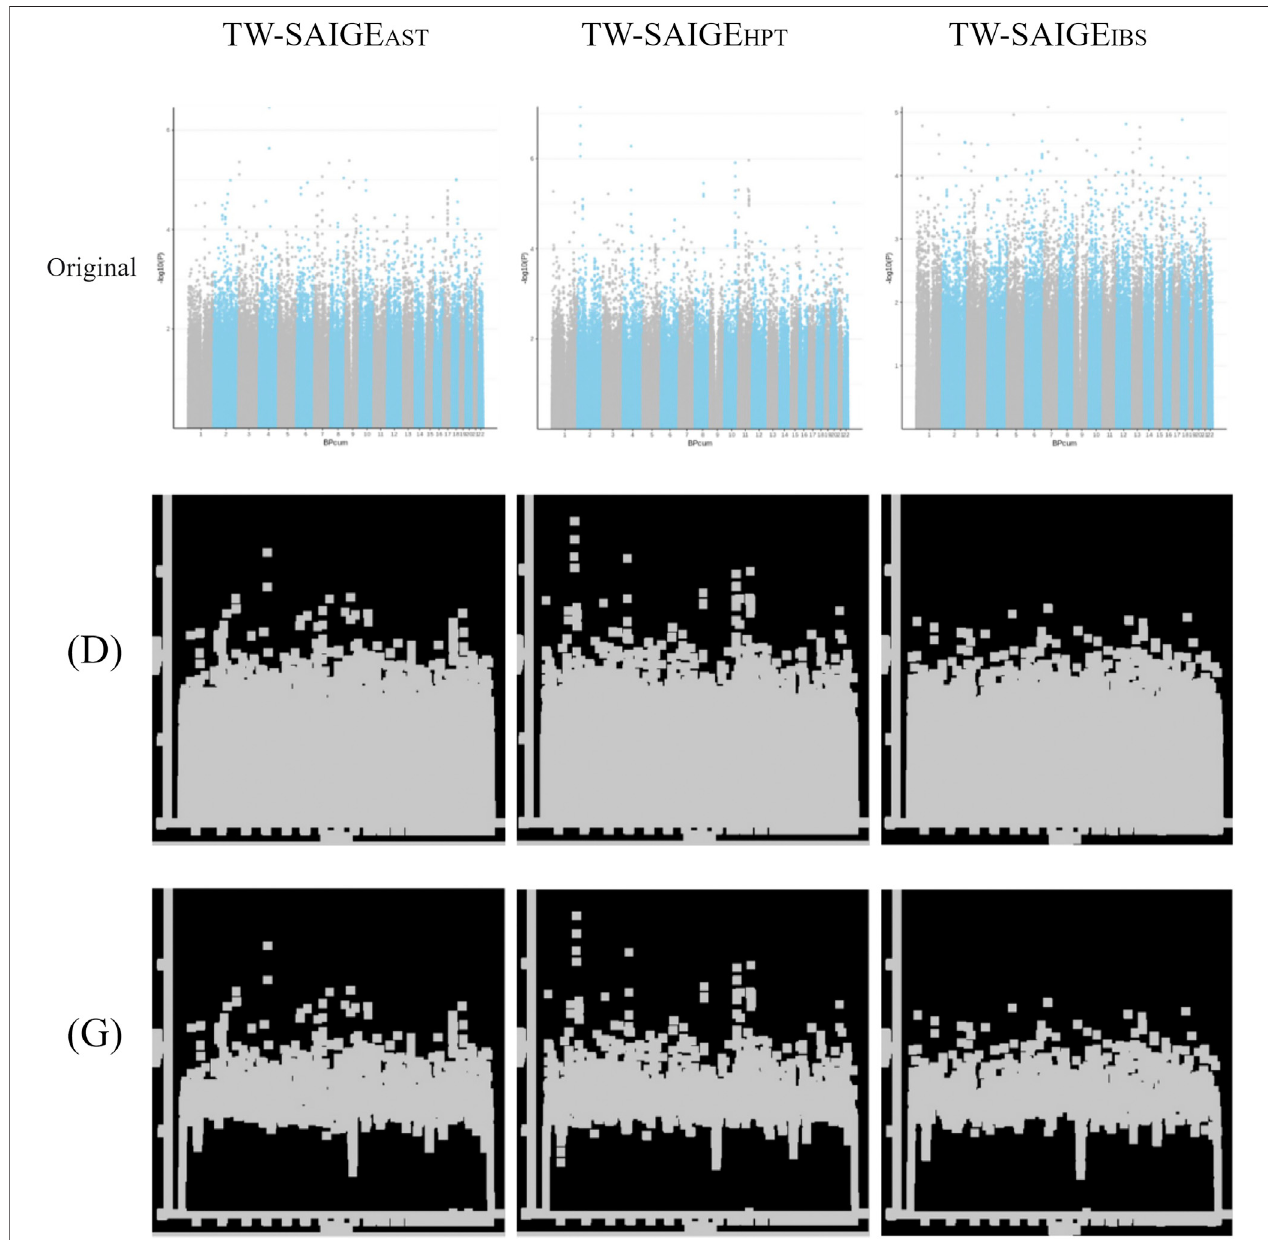
FIGURE 4 | Unprocessed Manhattan plots of TW-SAIGE AST , TW-SAIGE HPT , and TW-SAIGE IBS ( “ original ” labeled) were adjusted by image processing for dilation [(D) labeled] and morphological gradient calculation [(G) labeled].